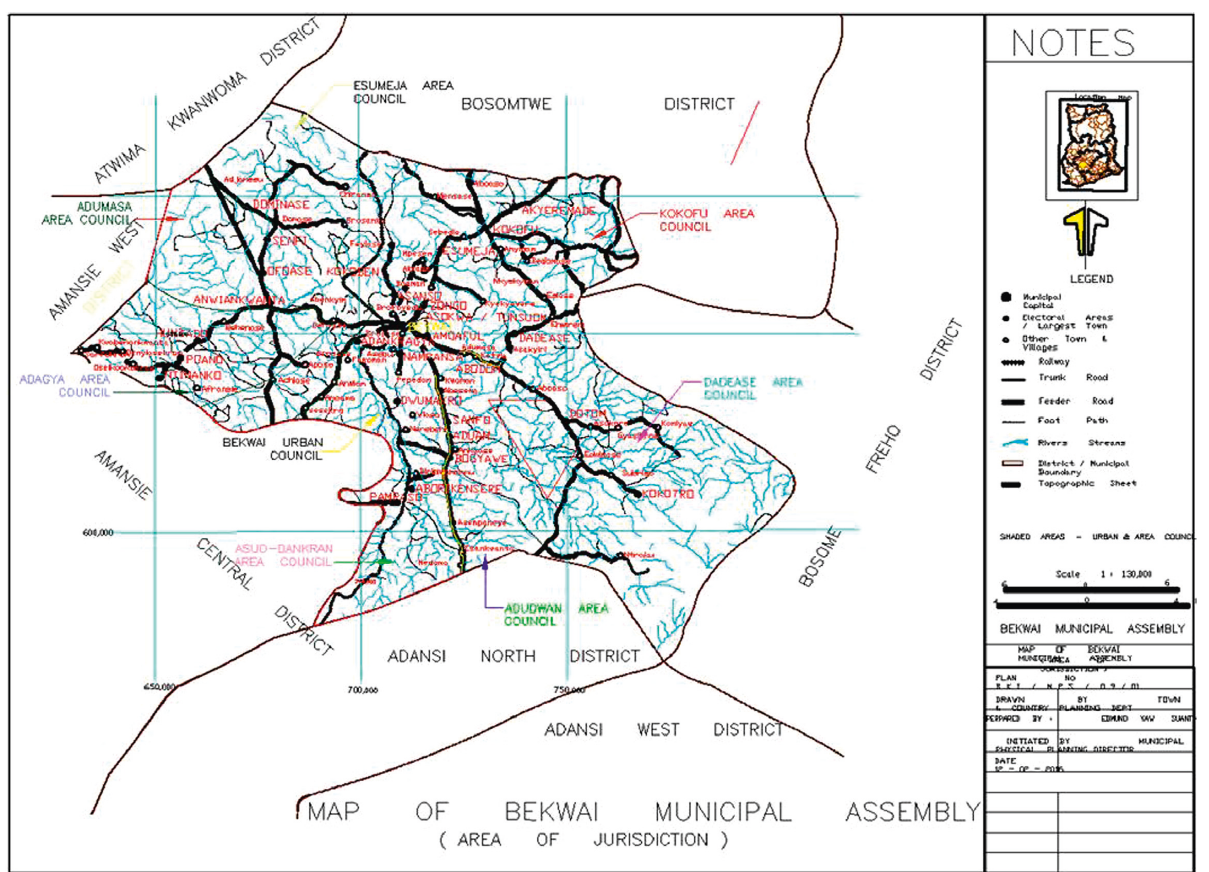
Figure 1: Map of Bekwai Municipal